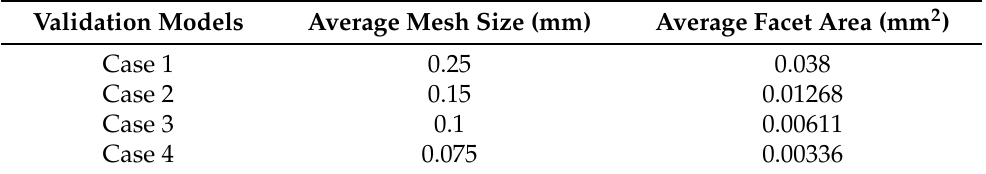
Table 2. Statistics of four FEM